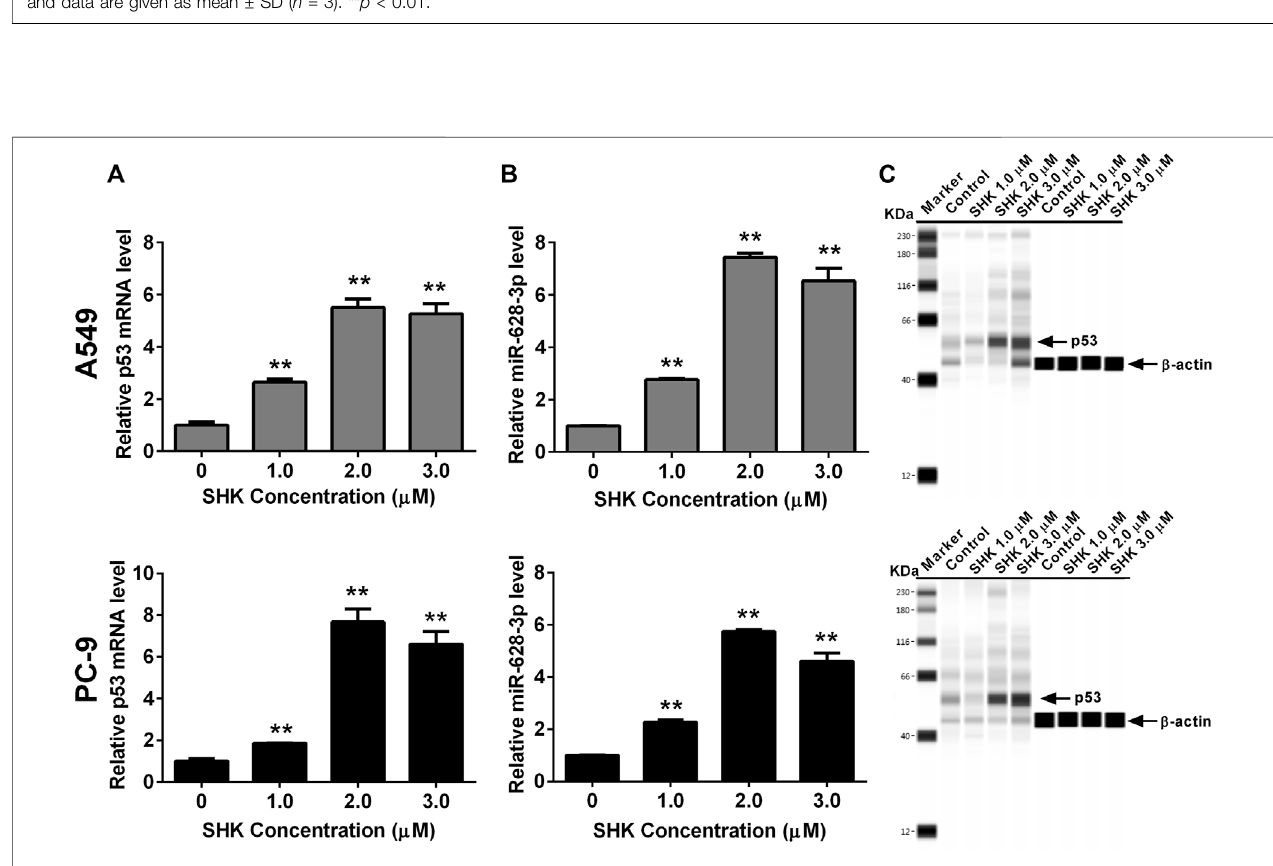
FIGURE3| SHKinducestheexpressionofp53andmiR-628-3ponA549andPC-9cells.CellsweretreatedwithdifferentconcentrationsofSHKfor24 h,andthen the relative p53 (A) and (B) miR-628-3p mRNA levels were measured by qRT - PCR, and (C) relative p53 protein expression levels were recorded by simple Western immunoblotting method. All measurements were carried out in triplicates, and data are given as mean ± SD ( n (cid:2) 3). * p < 0.05, ** p < 0.01.